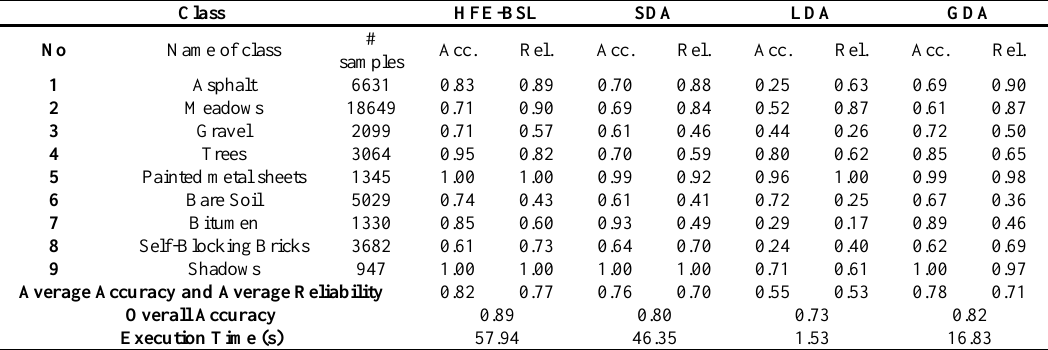
Table 2. Accuracies and reliabilities obtained for each class of Pavia dataset using 8 extracted features and 16 training samples.